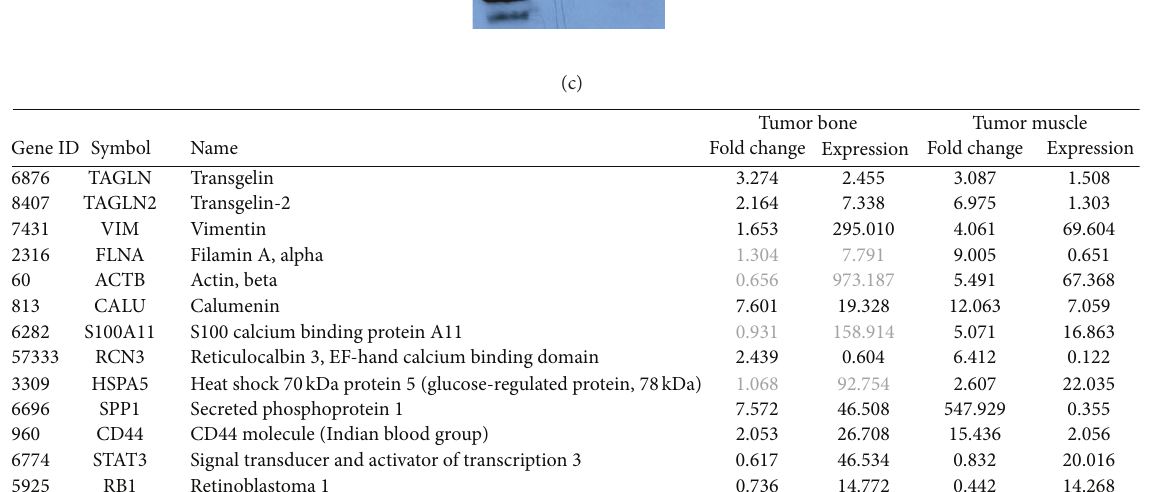
Figure 4: Protein overexpression. (a) 2D protein gel electrophoresis of lysates from muscle (upper left), tumor (upper right), and bone (bottom) in RIPA buffer. Red circles indicate the spots that were identified as overexpressed and were further analyzed by mass spectrometry. (b) Proteins identified in 2D gel electrophoresis as overexpressed in the tumor in comparison to muscle and bone were analyzed for their identity by mass spectrometry. The left column indicates the spot number corresponding to the 2D gel. The next column contains the protein name, followed by the accession number and a description of the protein function. The protein functions are grouped into structural, calcium homeostasis, and various others. (c) Western blot. 10 𝜇 g lysates of tumor, muscle, and bone in RIPA buffer were loaded per lane and electrophoresed on 10% SDS-polyacrylamide minigels with reducing, denaturing sample buffer. After transfer to PVDF membranes, they were probed for markers of cancer progression, including osteopontin, CD44, STAT3, and phospho-STAT3. Antitubulin served as a loading control. (d) RNA levels corresponding to the proteins found to be affected in the sarcoma. With four exceptions in the tumor-bone comparison (gray font), upregulated proteins are associated with increased RNA levels. STAT3 is not increased on the protein or RNA level. The reduced level of RB1 expression is consistent with the elevated DNA binding activity of